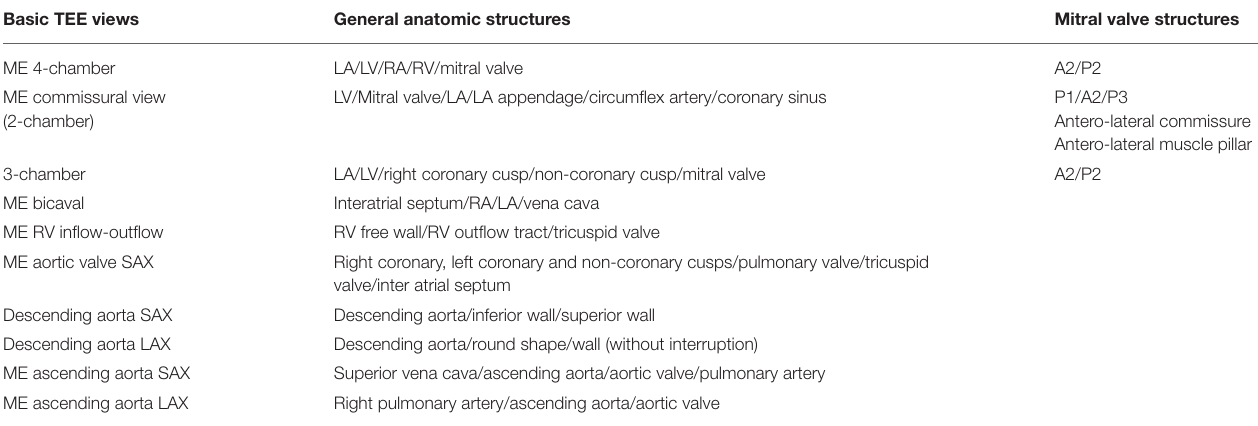
TABLE 1 | List of basic TEE views, general anatomic structures (25, 26) and the mitral valve structures (27) that will be assessed in the study. Basic TEE